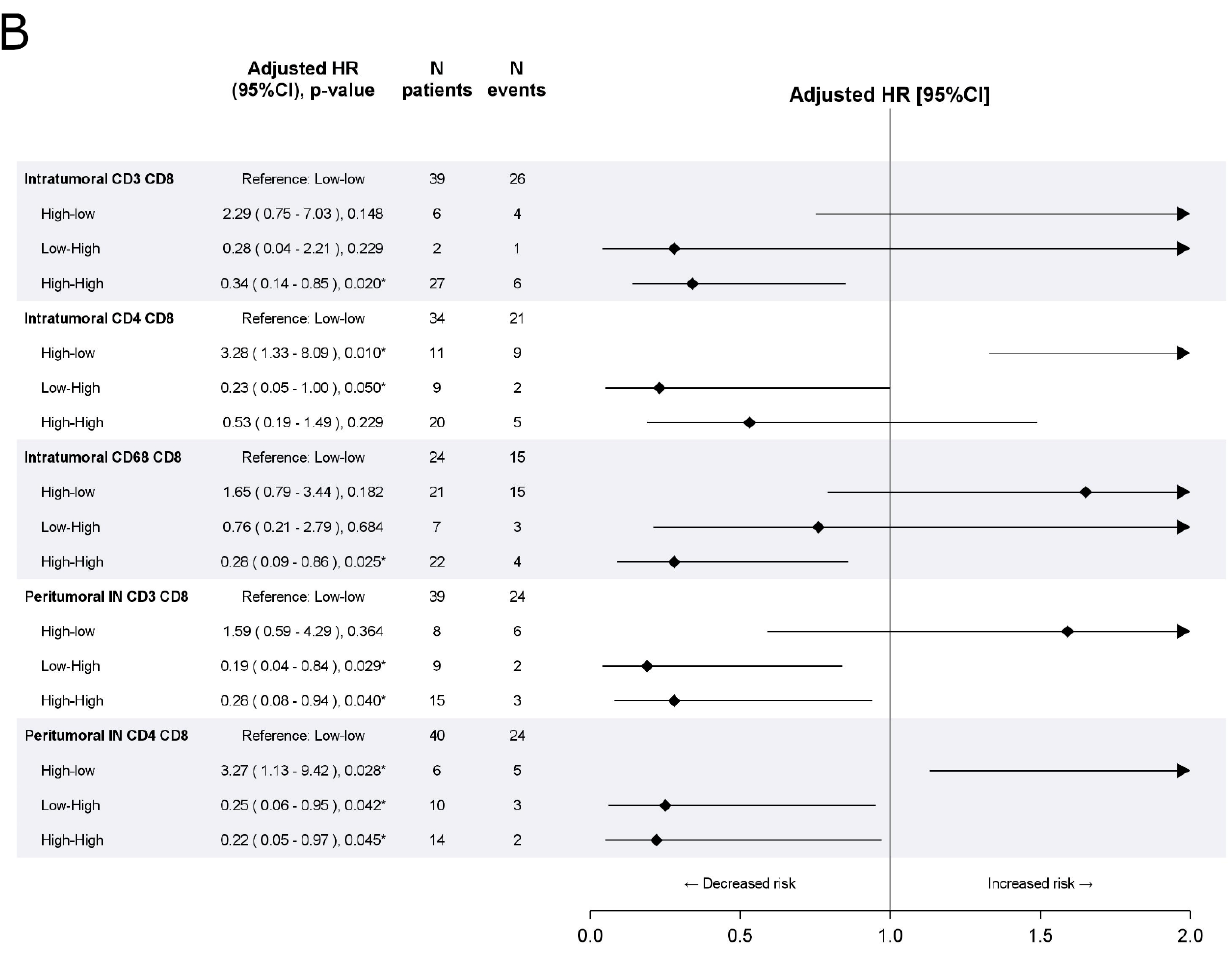
Figure 3. Effect of combination with CD8 + density on disease free survival ( A ) and overall survival ( B ) in the validation cohort. Multivariable Cox proportional hazard models.* indicates significant p -value at 0.05